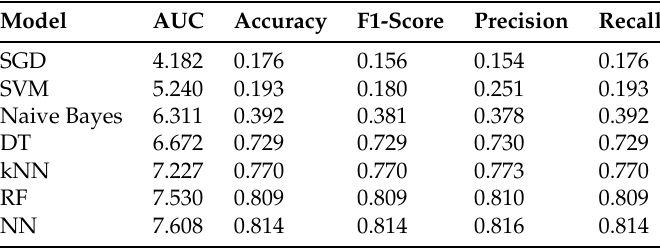
Table 13. Classification results using processed accelerometer, and gyroscope measurements.